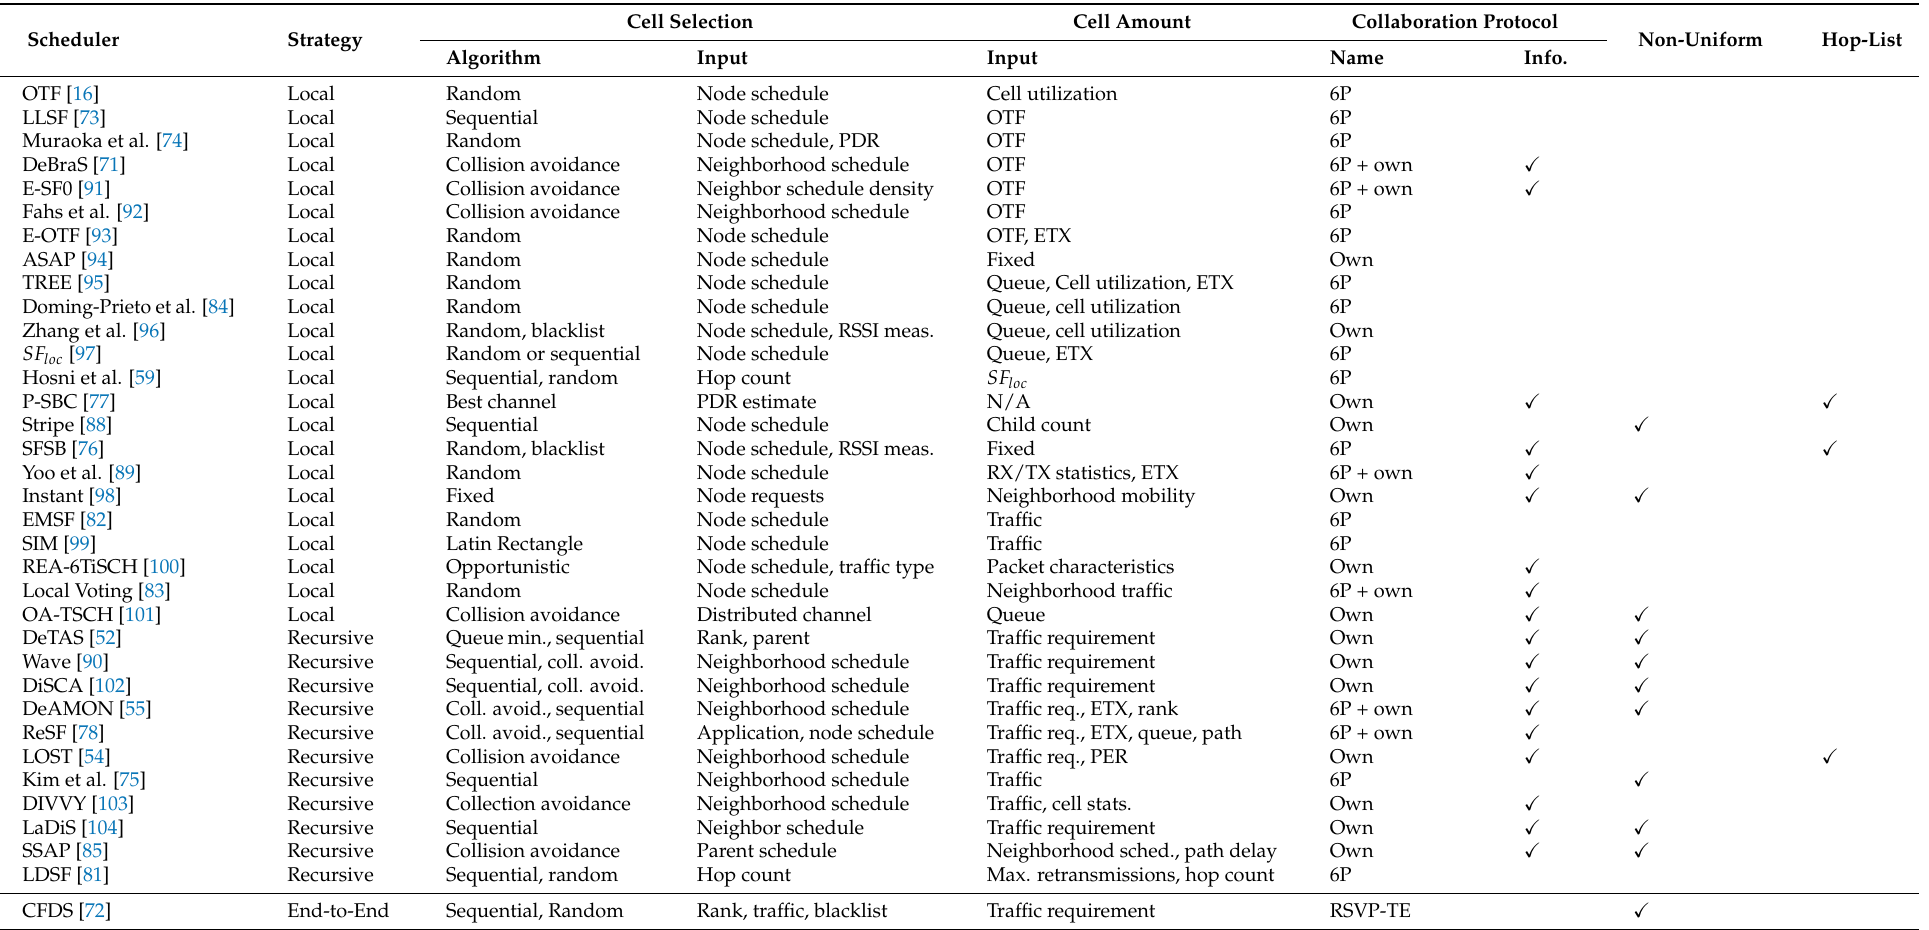
Table 3. Components of collaborative TSCH